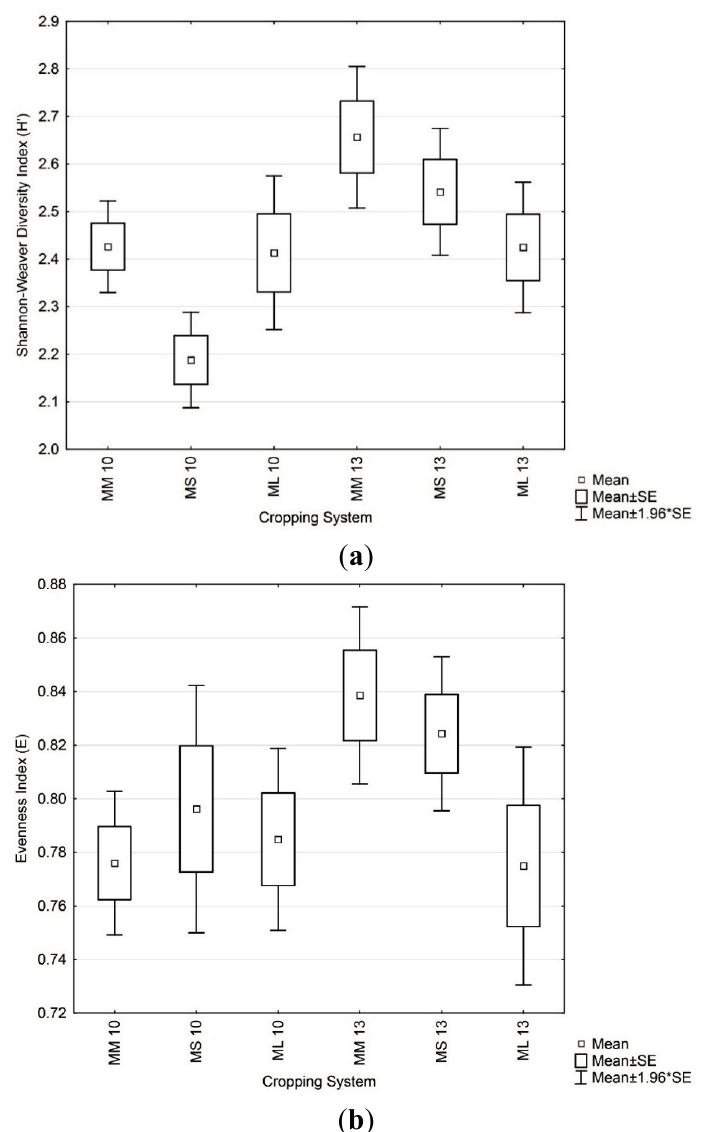
Figure 5. ( a ) Box and Whisker plots comparing the effect of cropping systems on soil microbial species richness (Shannon–Weaver Index) during the 2009/2010 and 2012/2013 planting seasons. ( b ) Box and Whisker plots comparing the effect of cropping systems on soil microbial species abundance (Evenness Index) during the 2009/2010 and 2012/2013 planting